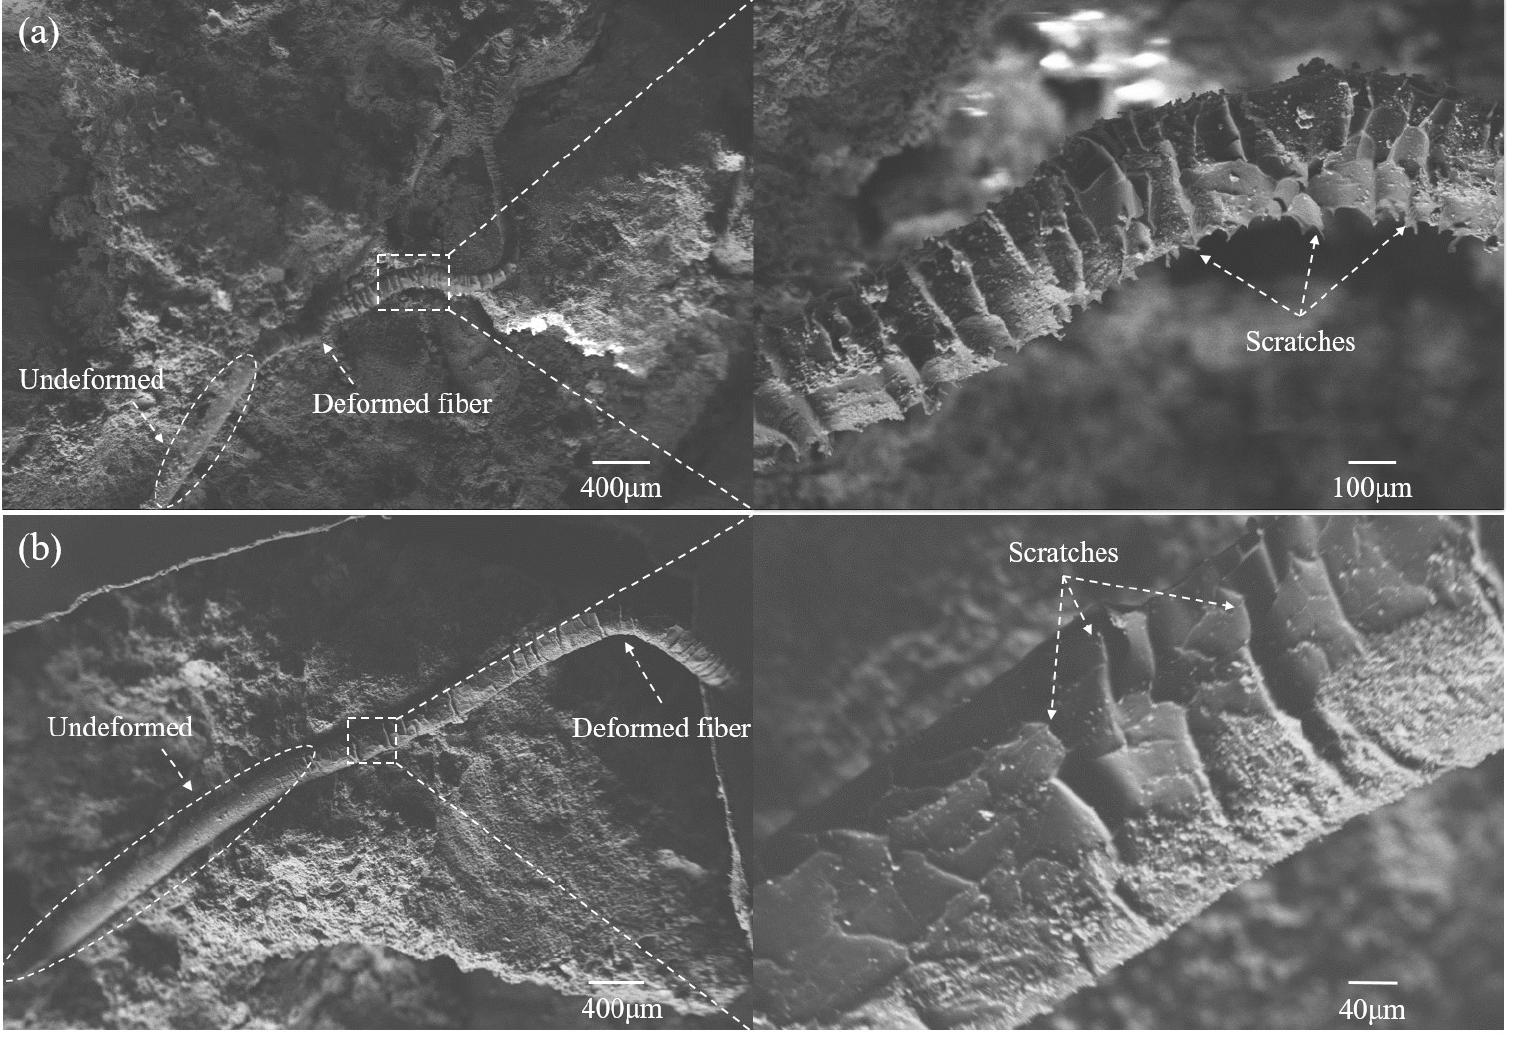
Figure 12. Microscopic image of bent and deformed fibers in PP12-0.3. ( a ) Area 1; ( b ) Area 2.